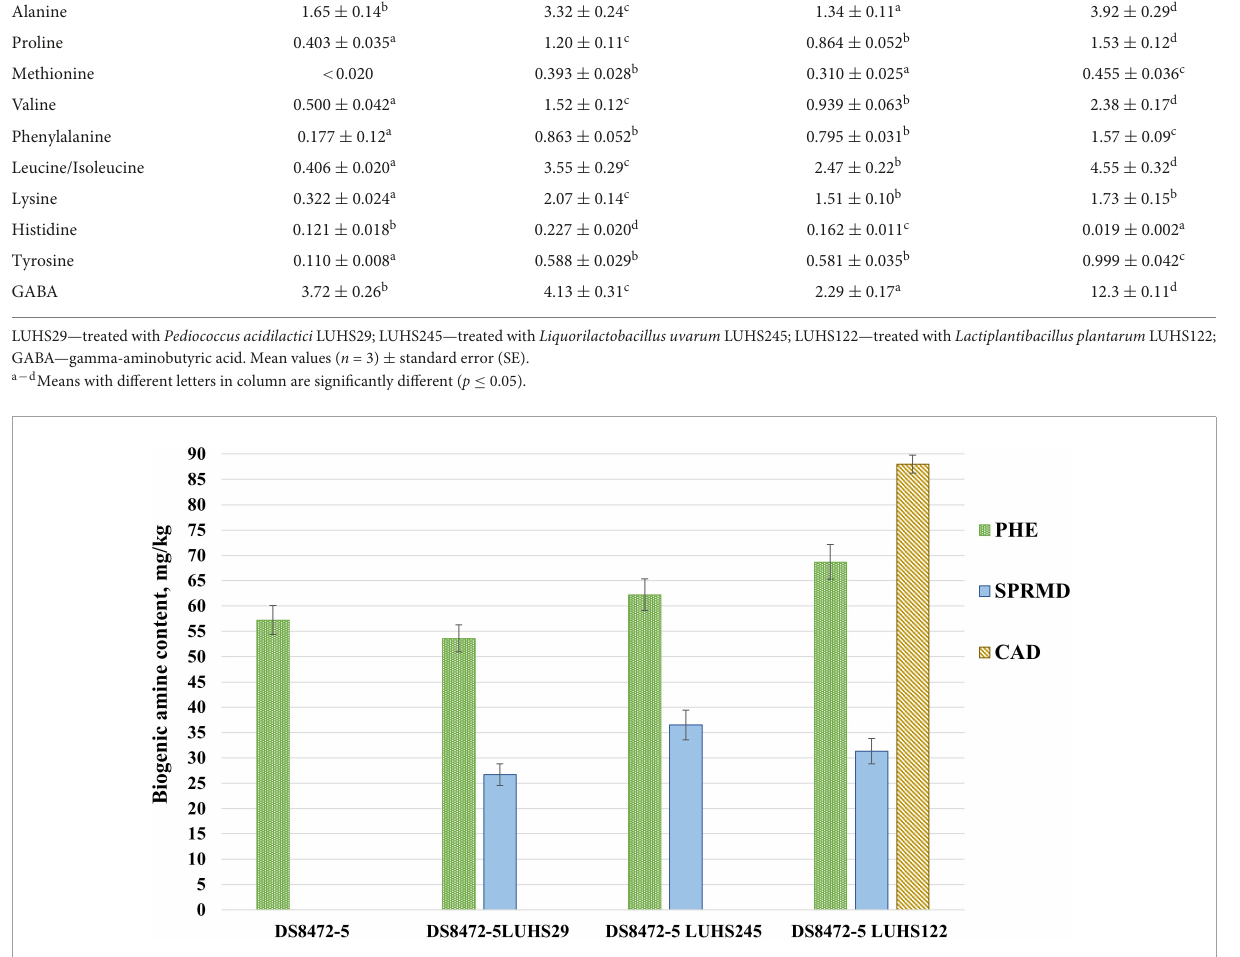
FIGURE3 Biogenic amine (BA) concentration (mg/kg) in wheat cereal wholemeal (WCW) (DS8472-5) samples. LUHS29, treated with Pediococcus acidilactici LUHS29; LUHS245, treated with Liquorilactobacillus uvarum LUHS245; LUHS122, treated with Lactiplantibacillus plantarum LUHS122. PHE, phenylethylamine; CAD, cadaverine; SPRMD, spermidine. Results presented as the mean ( n = 3) ± standard error (SE). a , b Means with different letters in column are significantly different ( p ≤